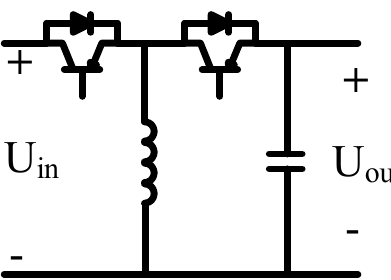
Figure 6. Topology of half-bridge bidirectional DC/DC converters. The BUCK-BOOST bidirectional DC/DC converter flange structure, in which the energy is stored and transferred through the inductor, is unsuitable for high-power applications. As with the half-bridge bidirectional DC/DC converter, the inductor current can be operated intermittently, but the peak current flow through the switching tubes becomes larger. The topology of the BUCK-BOOST bidirectional DC/DC converter is shown in Figure 7.